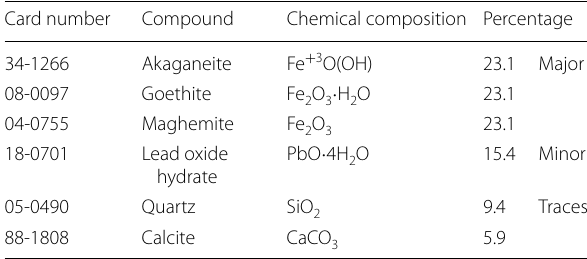
Table 2 XRD results of the corrosion products that formed on the ironwork units